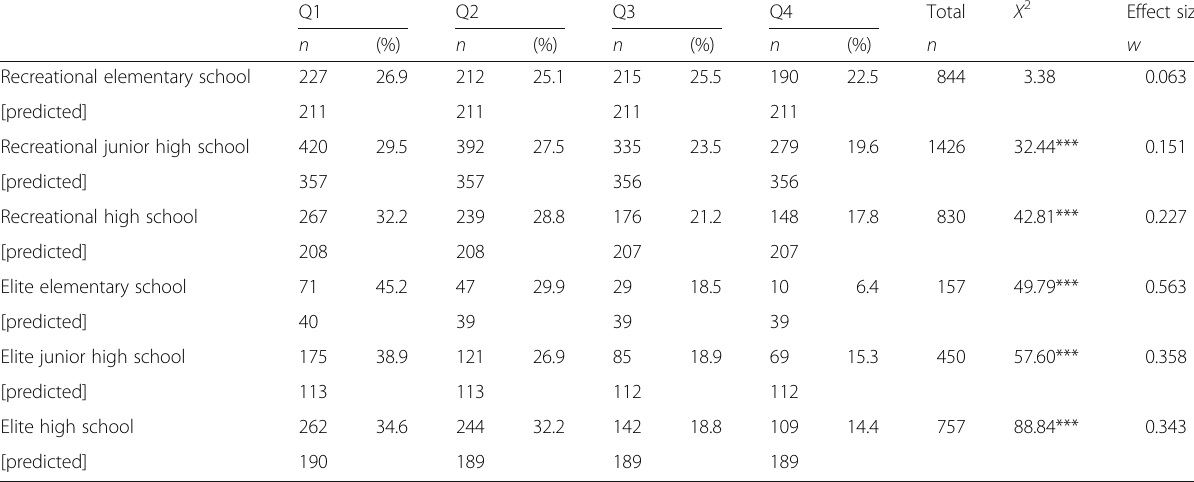
Table 3 Distribution of junior players divided into recreational and elite categories